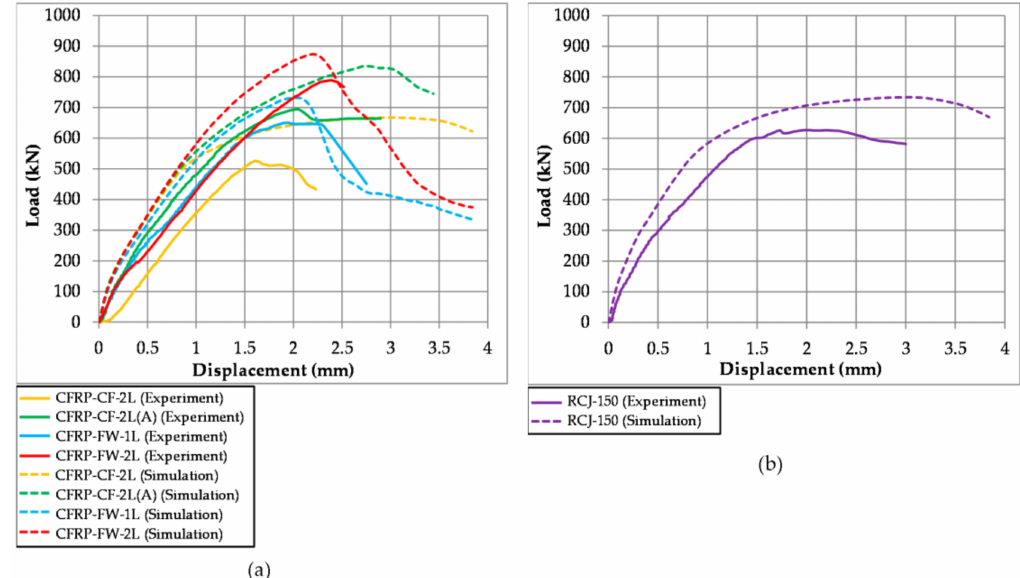
Figure 8. Load-displacement relationships for corbels of the retrofitting series: ( a ) CFRP series and ( b ) Reinforced concrete (RC) jacketing series.